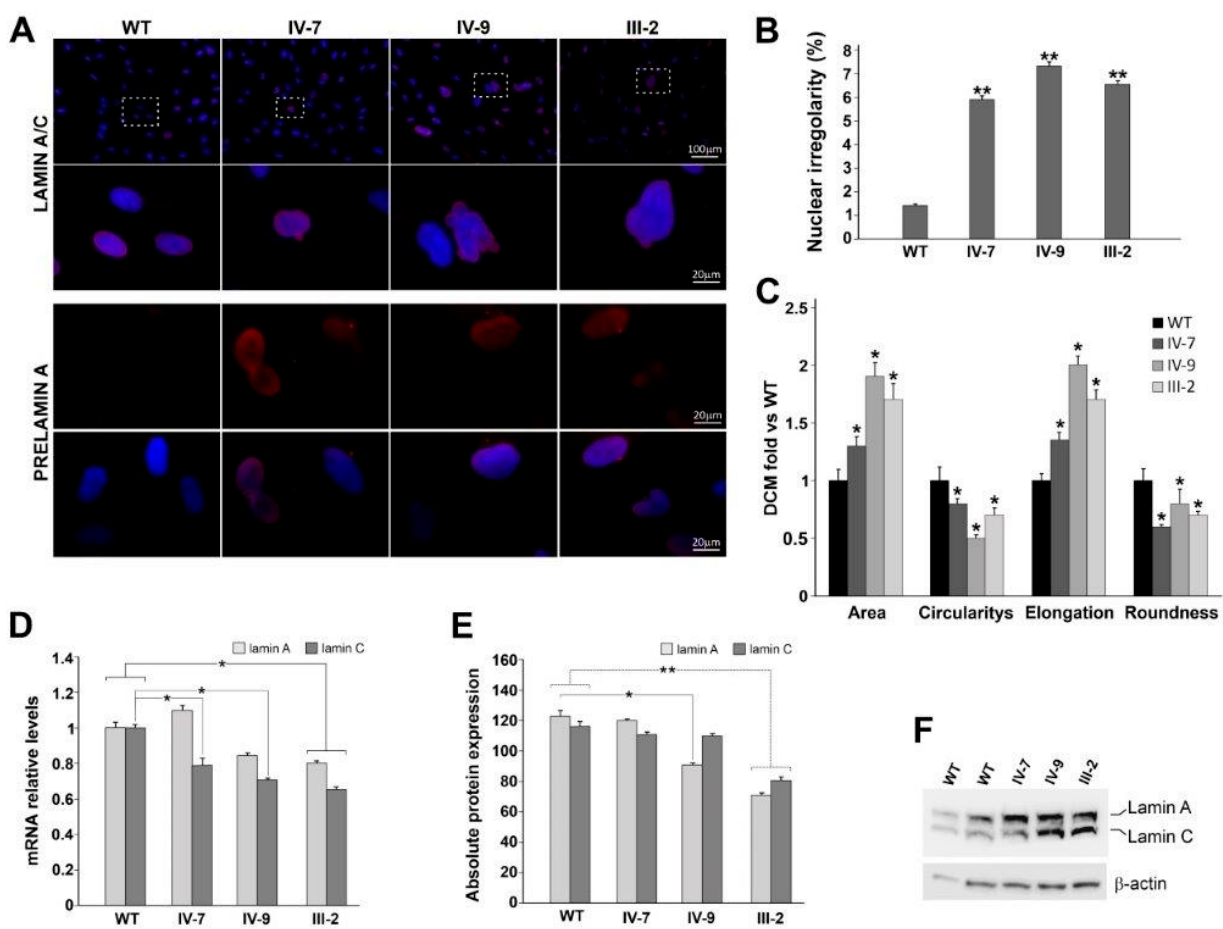
Figure 3. ( A ) Representative immunolabeling for lamin A/C (red) and Prelamin A (red) of WT and DCM HDFs (IV-7, IV-9, and III-2). Nuclei are counterstained with Hoechst 33,342 (blue). Scale bar 20 µ m, 100 µ m. ( B ) Percentage of WT and DCM cells with abnormal nuclear irregularities revealed in HDFs patients. Results represent three independent experiments with significant differences between WT and DCM HDFs (** p < 0.01). ( C ) Bar graphs represent the four parameters relative to nuclear shape (area; circularity; elongation; roundness); they are reported as mean values ± SD (fold DCM vs. WT) of three independent experiments. Significant differences are denoted by the p -value (Student’s two-tailed t-test; * p < 0.05. ( D ) RT-qPCR of lamin A and C transcripts in WT and DCM HDFs; GAPDH was used as reference gene. Data are from three independent experiments and represented as mean ± SD (* p < 0.05). ( E ) Densitometric analysis of Western blot performed on WT and DCM HDFs, showing the intensity of the band corresponding to lamin A and C normalized versus β -actin levels. WT densitometric value is the average between two different controls (* p < 0.05; ** p < 0.01). Data are presented as mean ± SD. ( F ) Representative Western blot of lamin A and C; β -actin is used as housekeeping